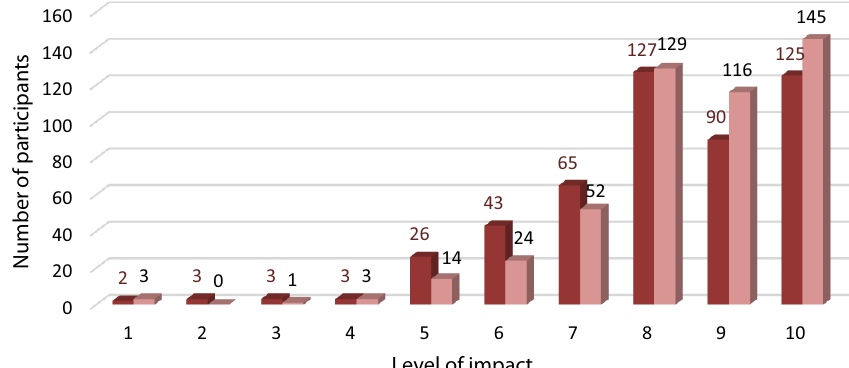
Figure 5: Perceived negative impact of plastics on health.